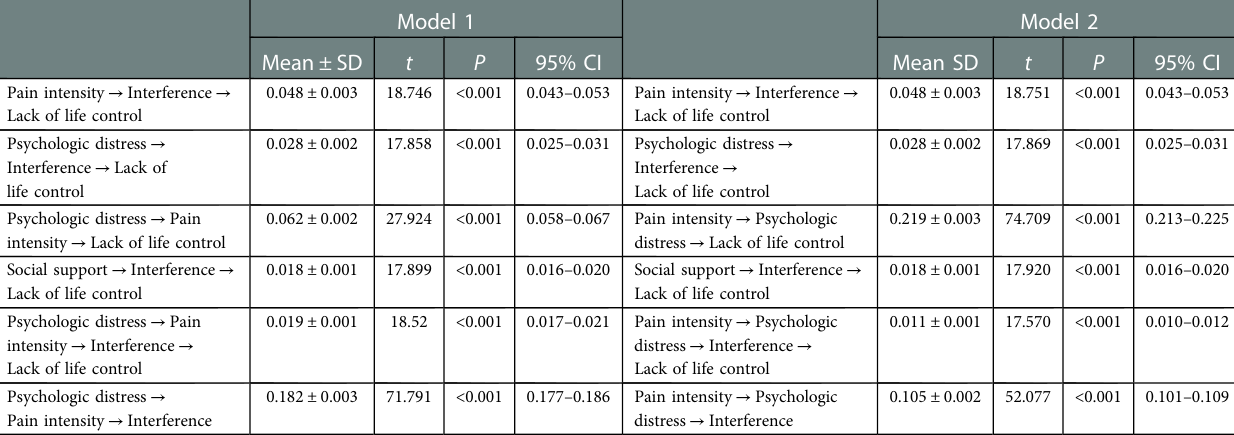
TABLE 4B Speci fi c indirect effects for the two models of the total cohort ( N =40,184). In model 1 psychological distress → Pain intensity and in model 2 the opposite (i.e., Pain intensity → Psychological distress). Mean±SD, t -values, P -values, and 95% con fi dence intervals (95% CI) are